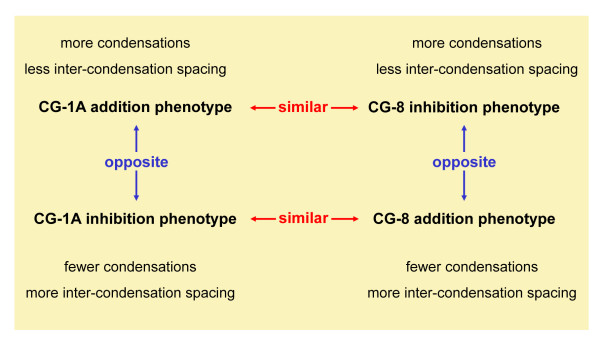
Scheme of effects of CG-1A and -8 perturbations on condensation pattern in vitro.